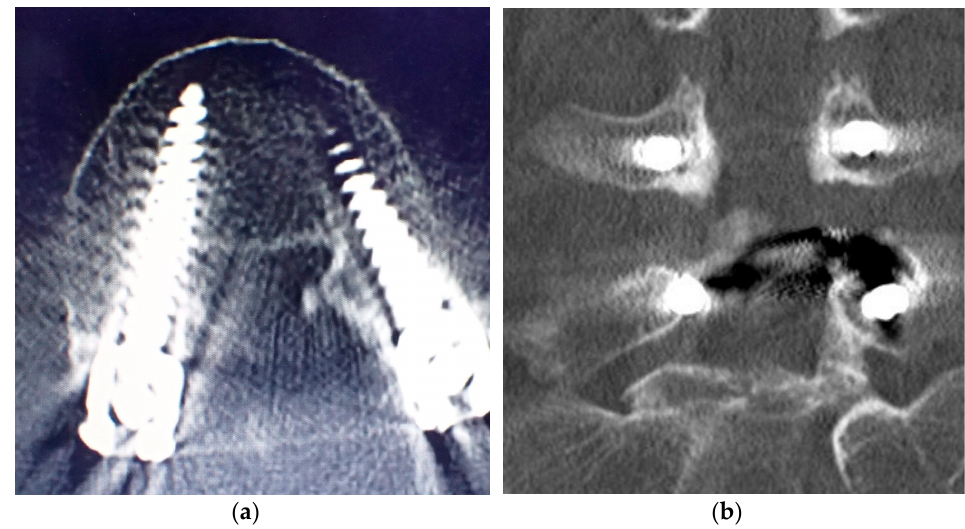
Figure 7. ( a , b ) Computed tomography scan of the screw deviation to the medial pedicle wall in